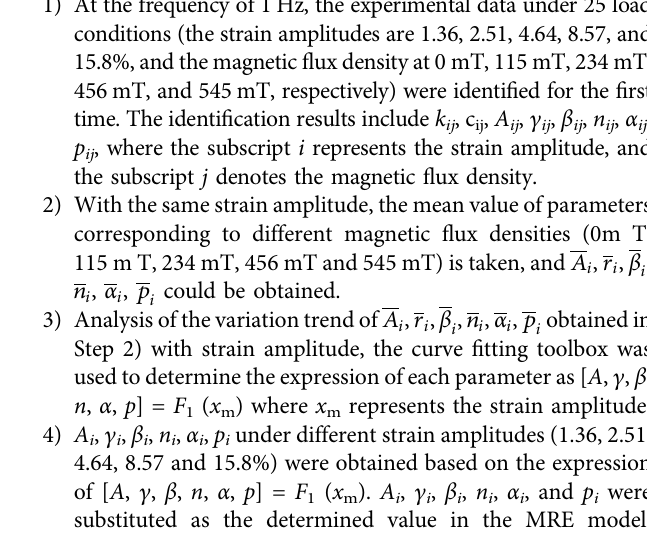
Frontiers in Materials |